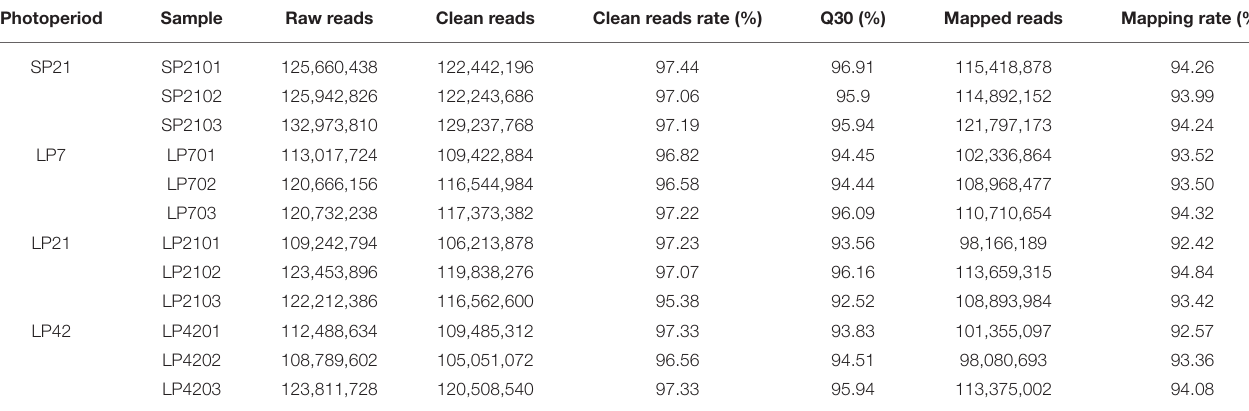
TABLE 1 | Summary of raw reads after quality control and mapping to the reference genome.